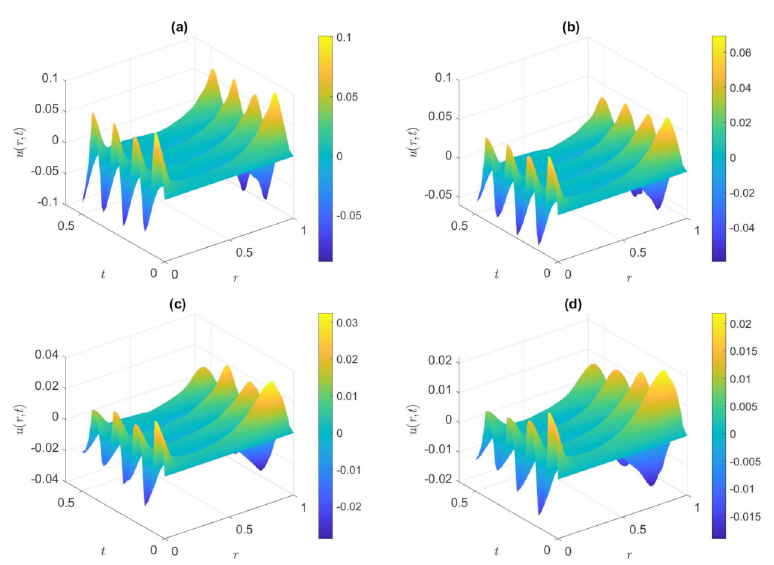
Figure 5. Dimensionless axial velocity distribution of the square waveform in the microtube